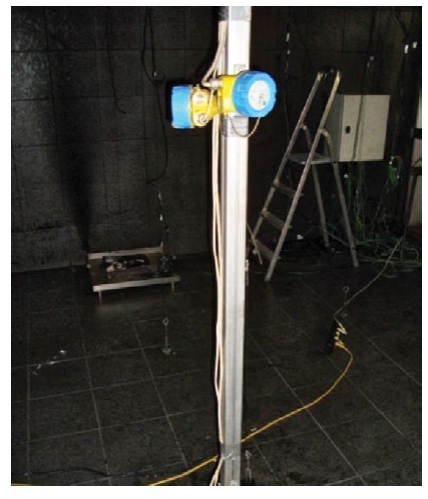
Fig. 13. A view of the aluminium column with mounted sensors MG 72